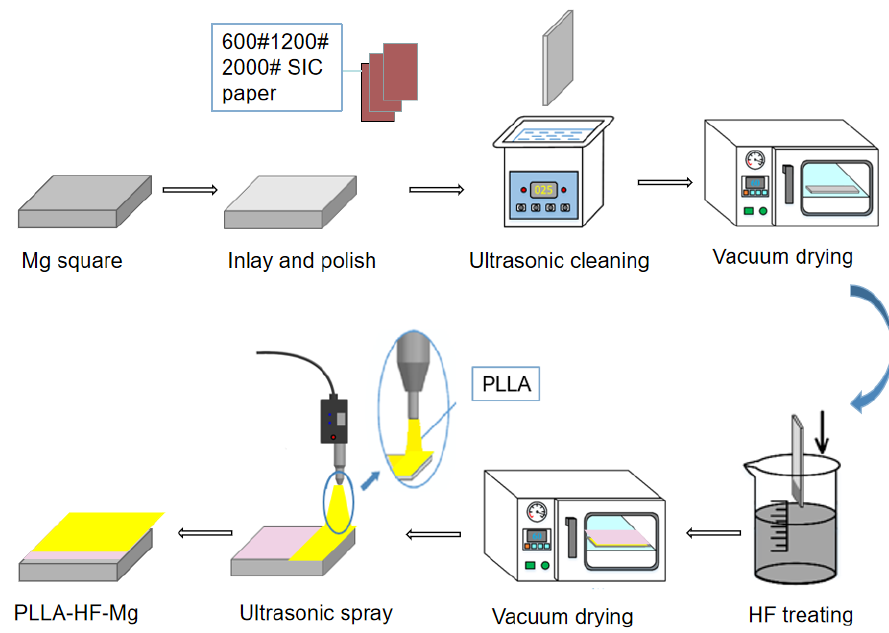
Figure 1. Preparing process of